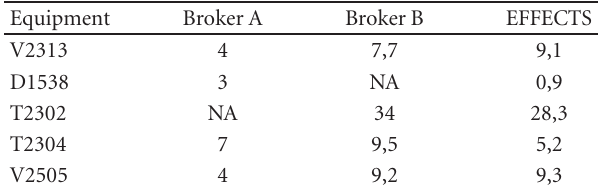
Table 4: Explosive mass in clouds [t] calculated by three di ff erent tools.